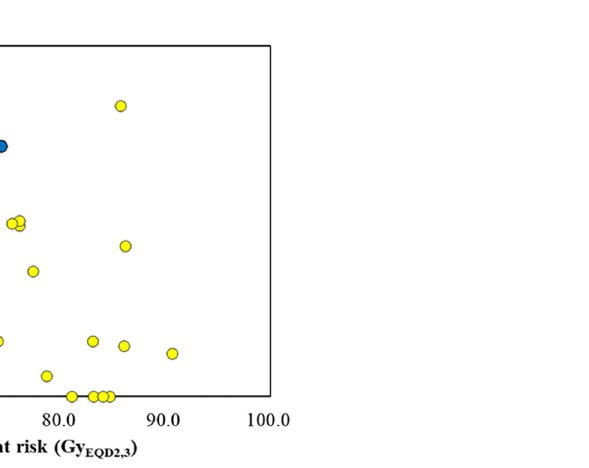
FIGURE 3 | The scatter plot of late gastrointestinal (blue) and genitourinary (yellow) toxicity versus maximum D2cc of rectum, sigmoid, and small bowel and D2cc of